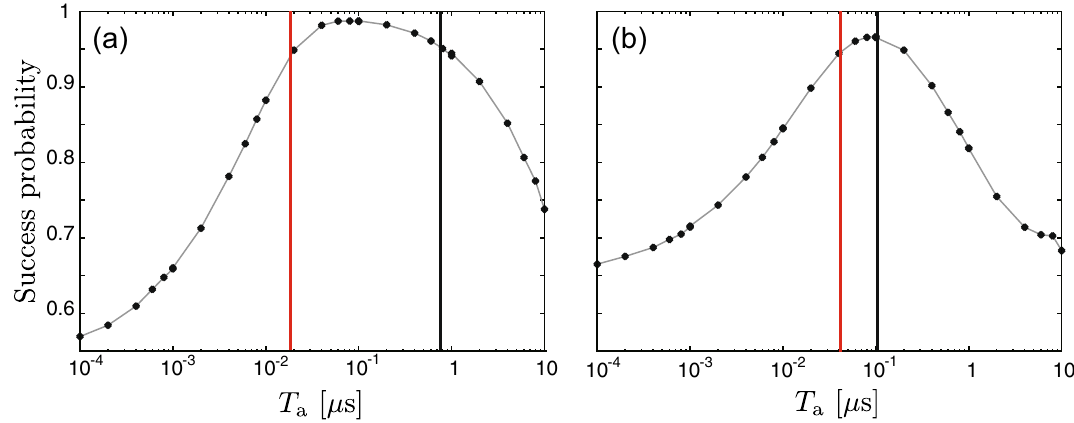
χ , β χ , β χ ( a ) and κ χ/ 2 for κ ] = = = = 1.38 0.18 i and α 0.90 0.24 i , respectively. = − = −